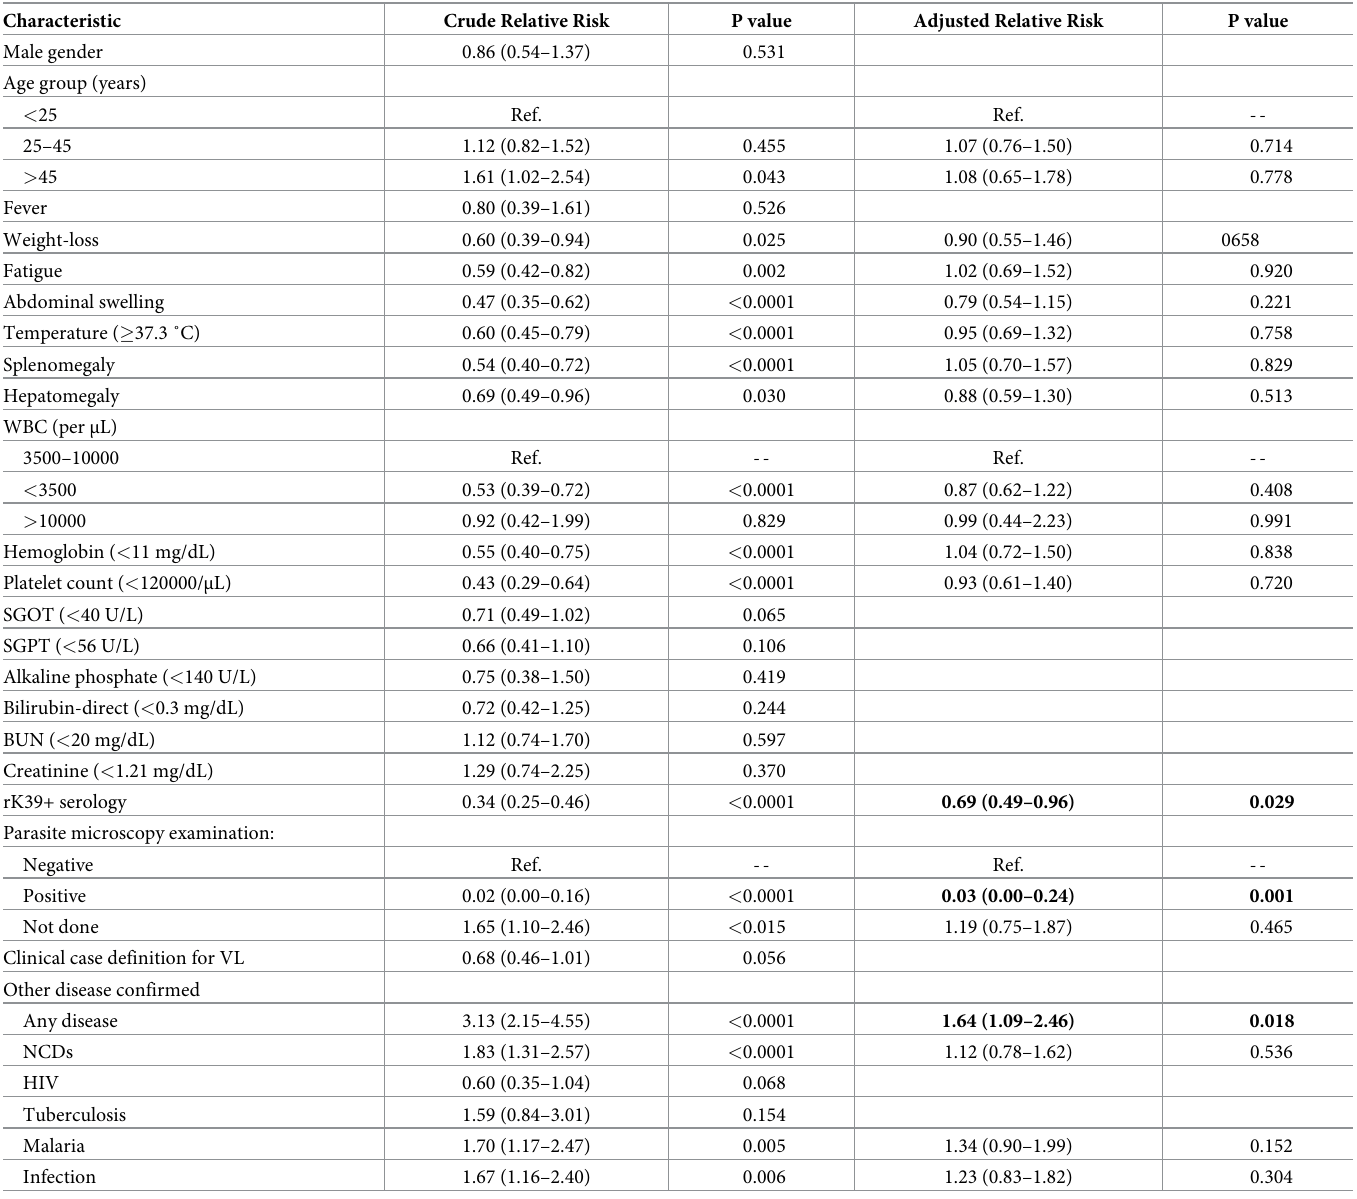
Table 2. Factors associated with initiation of non-VL